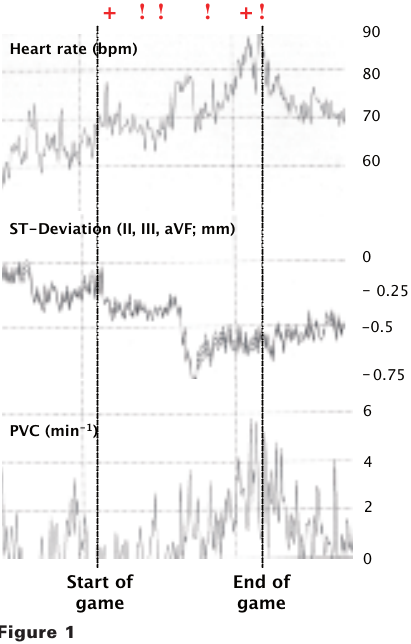
Continuous recordings of heart rate (top), ST-segment deviation (middle) and number of premature ventricular complexes (PVC; bottom) in a patient with CAD and reduced left ventricular function during watching a football game. Note the increase in heart rate, the pro- gressive depression of ST-segments in the in- ferior ECG leads and the increase in ventricular ectopia, suggestive of myocardial ischemia, particularly during the final 20–30, most hrilling minutes of the game. + goals scored by the Swiss team; ! goals scored by the Turkish